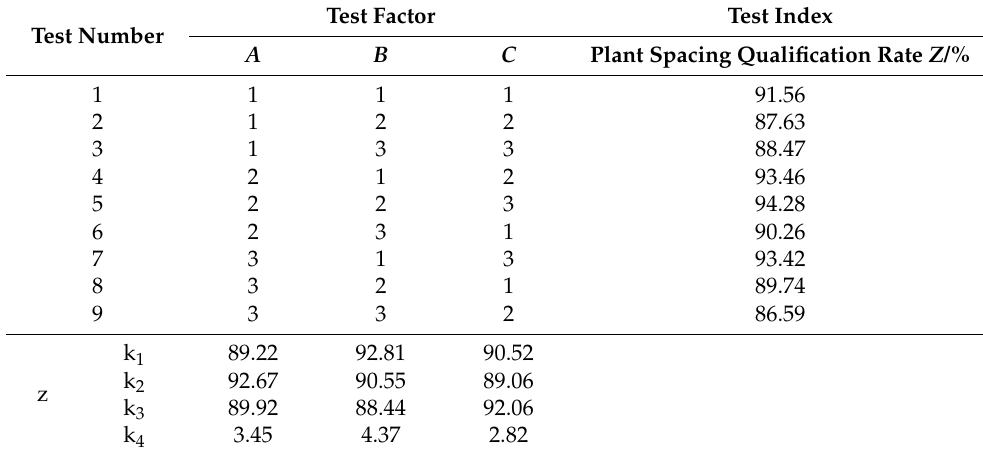
Table 3. Results and orthogonal test.